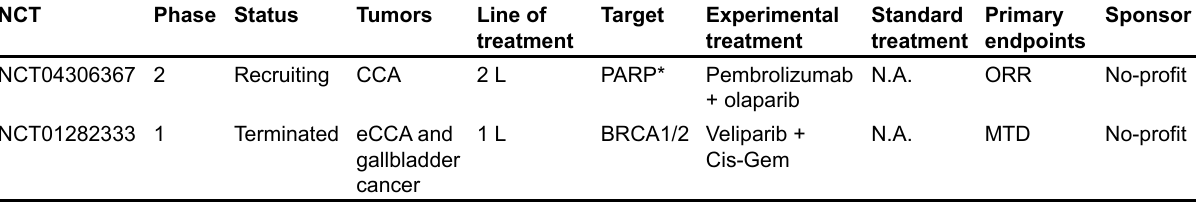
Table 2. Active trials, both recruiting and not recruiting, testing IDH and breast cancer gene (BRCA) inhibitors ( continued ) NCT Phase Status Tumors Line